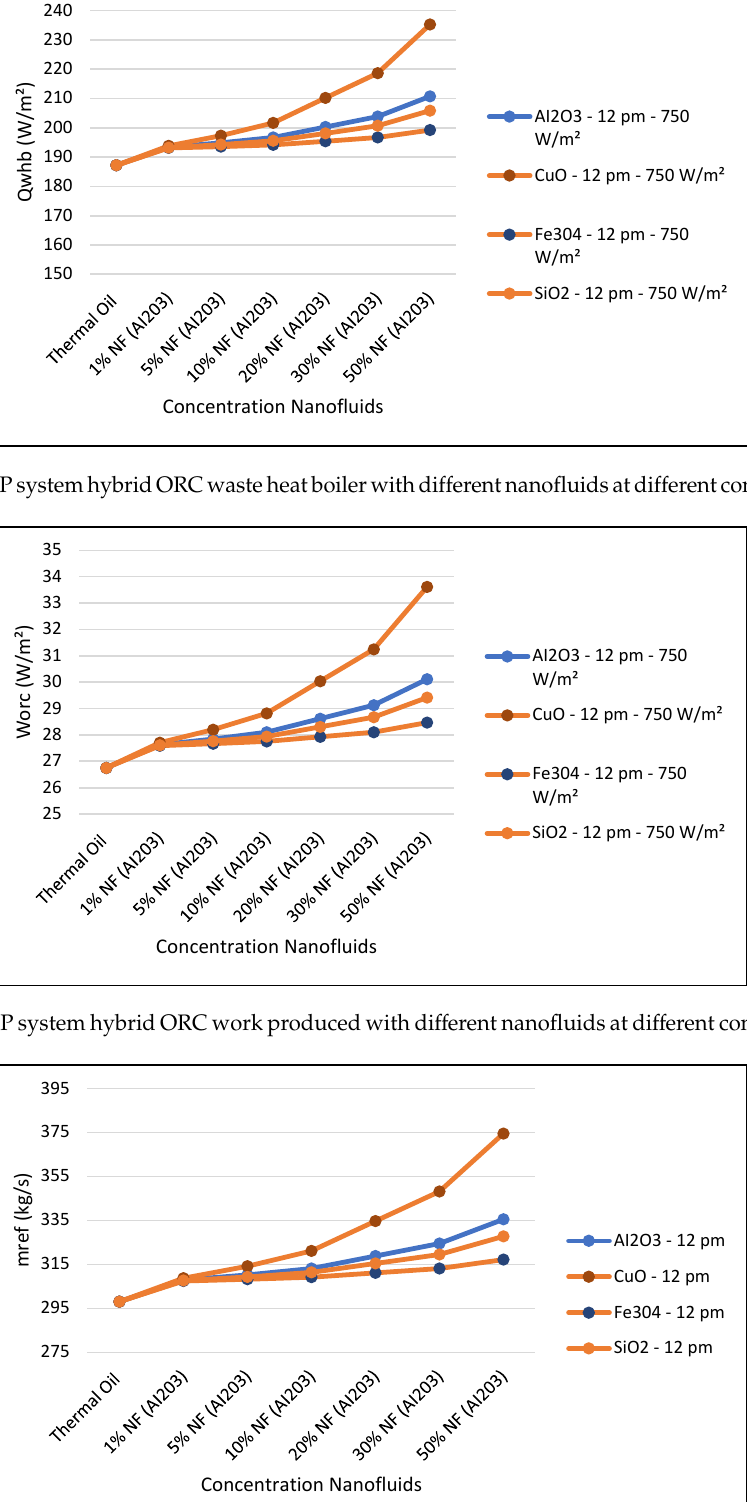
Figure 28. CSP system hybrid efficiency with different nanofluids at different concentrations. One of the significant parameters for demonstrating the enhancement of the CSP solar collector system is the ORC refrigerant mass flow rate, since this parameter impact the work produced by the ORC and the hybrid system efficiency. Figures 27 and 28 show the impact of the various nanofluids considered in this study on the aforementioned parameters. It appears that the higher the concentrations of nanofluids and the higher the solar radiation, the higher the refrigerant mass flow rate and ORC work produced and consequently the CSP hybrid system efficiency. Furthermore, Figures 25–28 also indicate that the nanofluid CuO outperforms other nanofluids Al 2 O 3, Fe 3 O 4 and SiO 2 and has the highest CSP solar collector performance compared to the other nanofluids and thermal oil base fluid under study. Therefore, Figures 29–31 were constructed to illustrate the impact of the concentrations of nanofluid CuO in the performance of the ORC system and the CSP hybrid system under different solar radiations at midday: 500, 750, 1000 and 1200 W/m 2 . As can be seen in Figure 29, the thermal